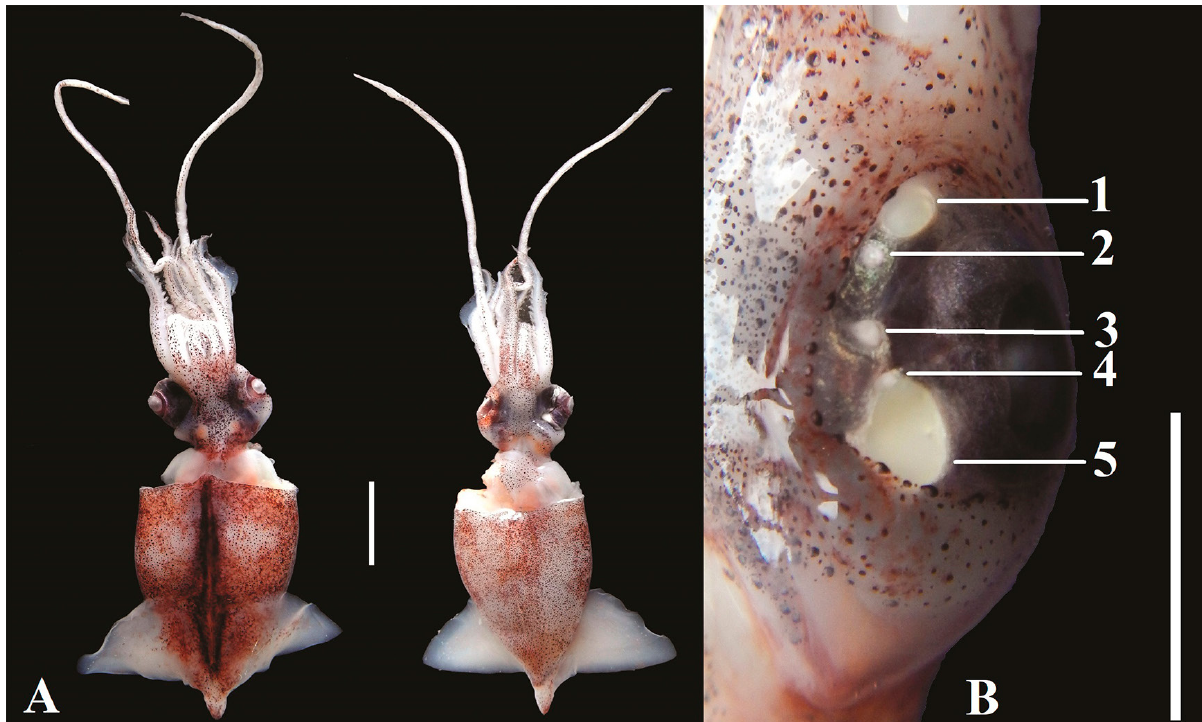
Fig. 1. – Dorsal and ventral view of Abralia andamanica collected from Arabian Sea (scale bar=2 cm) (A); view of ocular photophore in the ventral region of the eyeball (scale bar=1 cm)